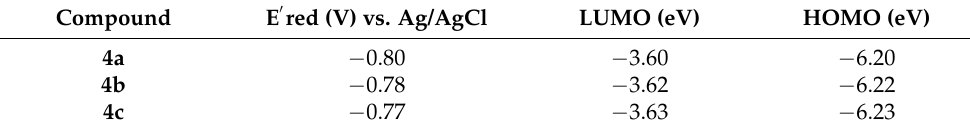
Table 2. Onset reduction potential (E (cid:48) red ), LUMO energies, and HOMO data obtained. Compound